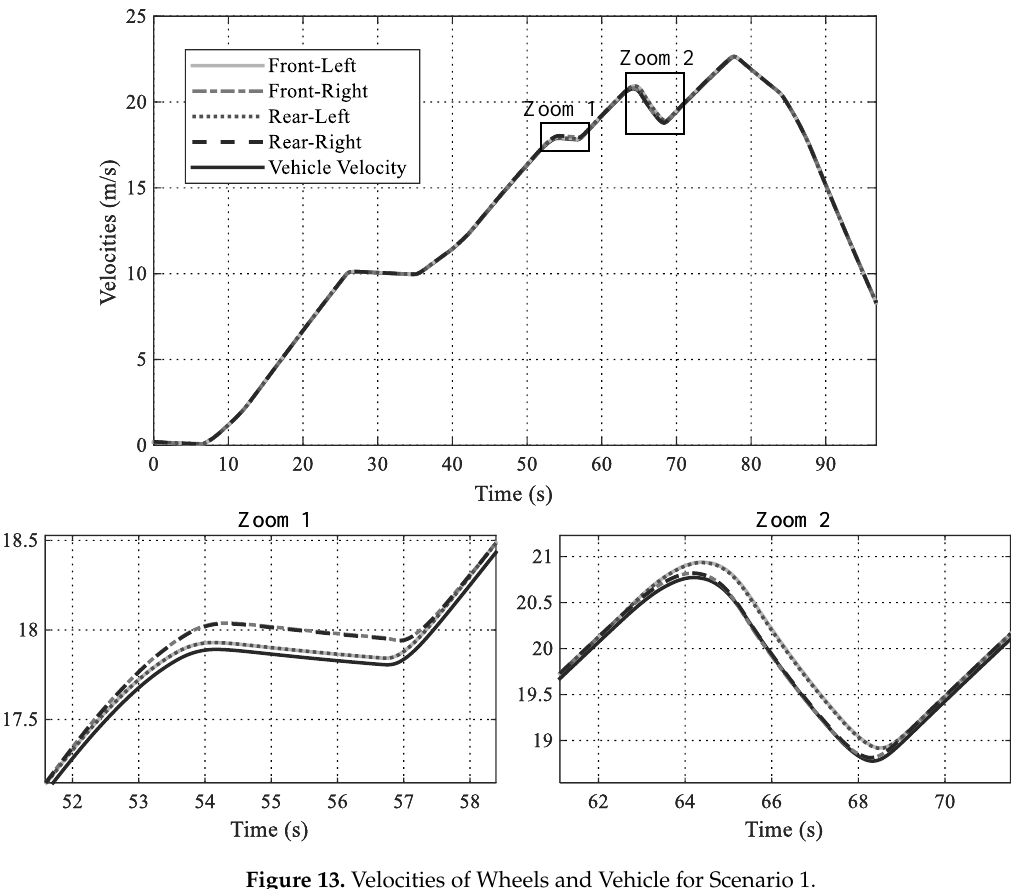
Figure 13. Velocities of Wheels and Vehicle for Scenario 1.